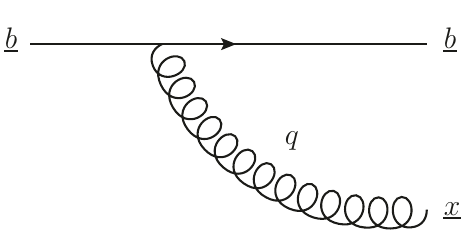
Figure 2 . The light-front wave function to radiate a soft gluon at mid-rapidity from a valence source, shown here as a